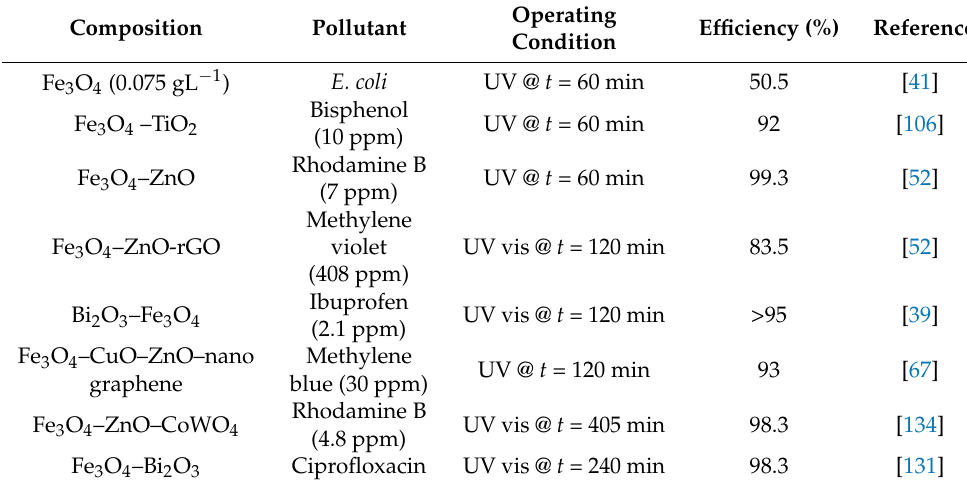
Table 10. Examples of magnetite heterojunction photocatalyst